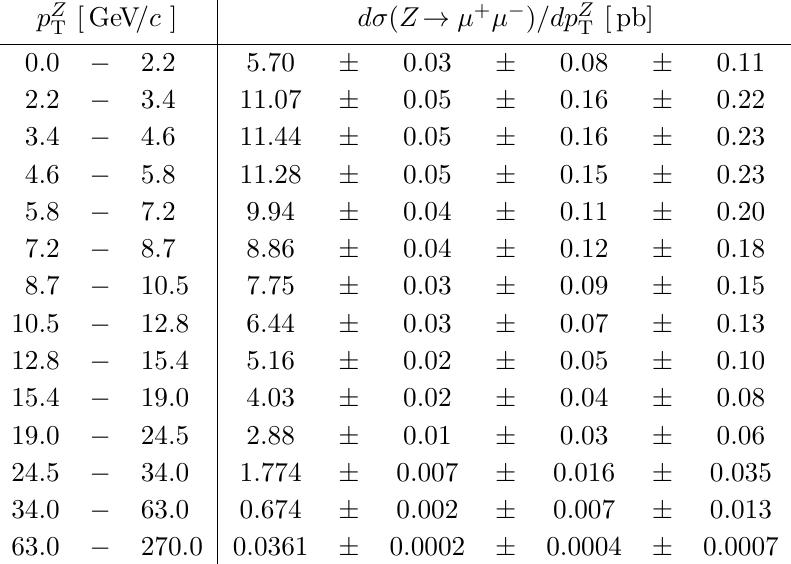
Table 15 . Measured single differential cross-sections in interval regions of p Z is statistical, the second systematic, and the third is due to the luminosity.